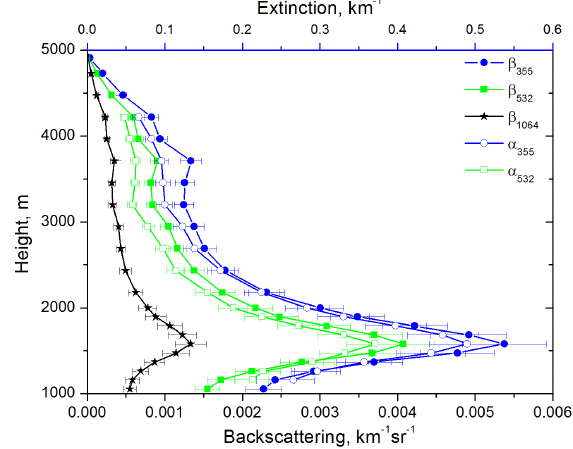
Figure 11. 3 β + 2 α optical data for time interval 03:20–05:20UTC on 28